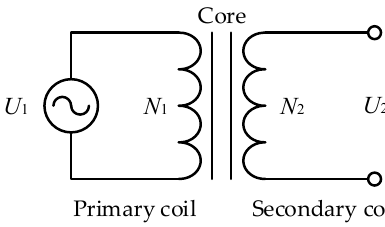
Figure 4. Basic principle of the inductive coupling principle.